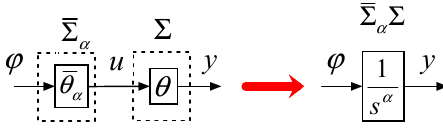
Figure 4. Schematic diagrams of the structures of the pseudo-linear system.